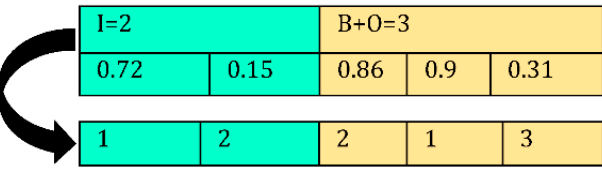
Table 2. Proposed priority-based decoding procedure of segment 1.